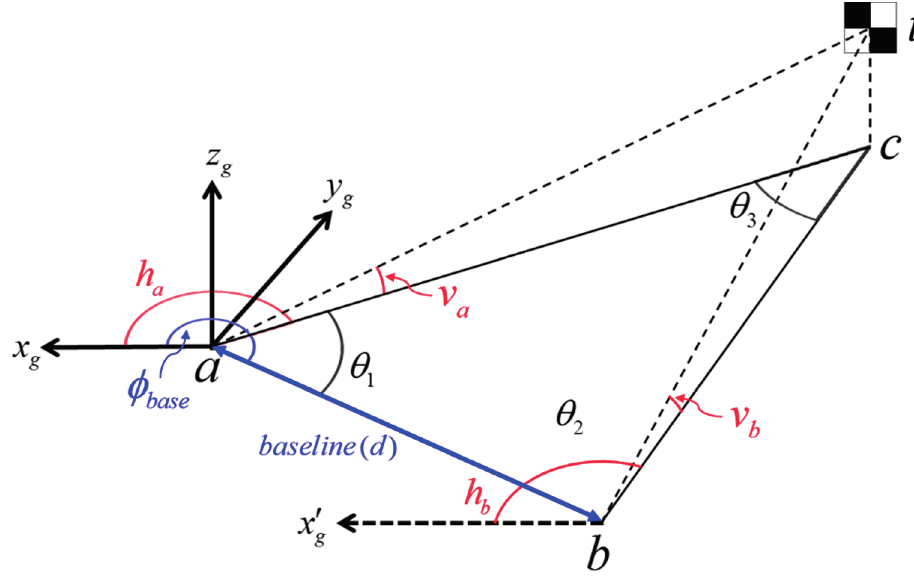
Figure 11. 3D triangulation for target detection using a total